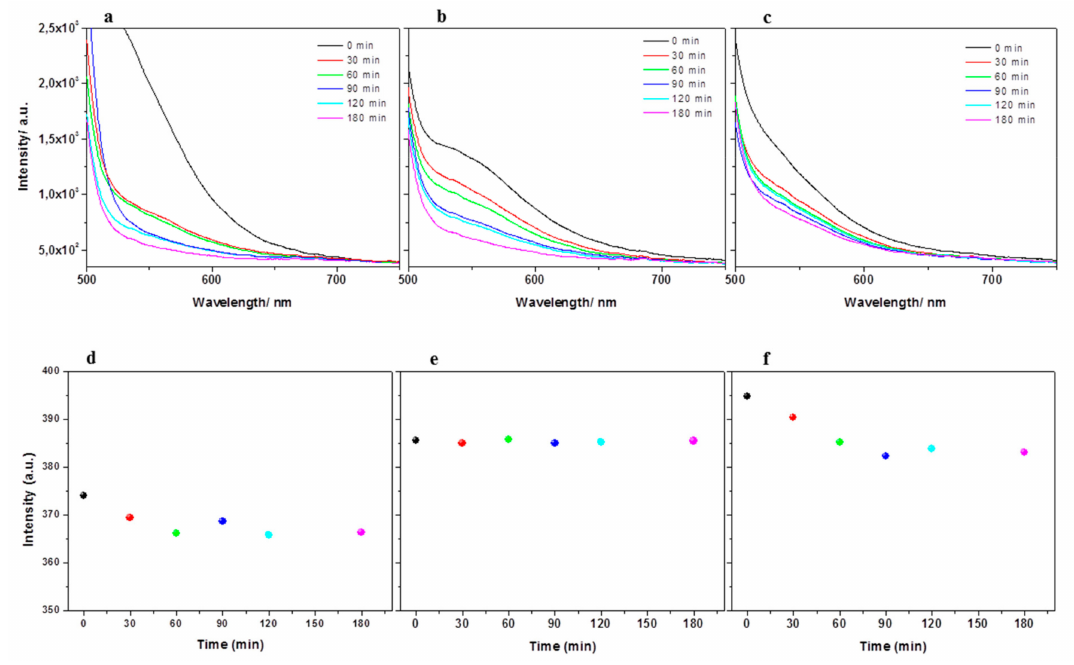
Figure 8. Fluorescence intensity profile in time of ( a , d ) [Tmi][Trif], ( b , e ) Cdots / [Bmim]Cl / [Tmi][Trif], and ( c , f ) CdotsCHI / [Bmim]Cl / [Tmi][Trif] entrapped in the PVA